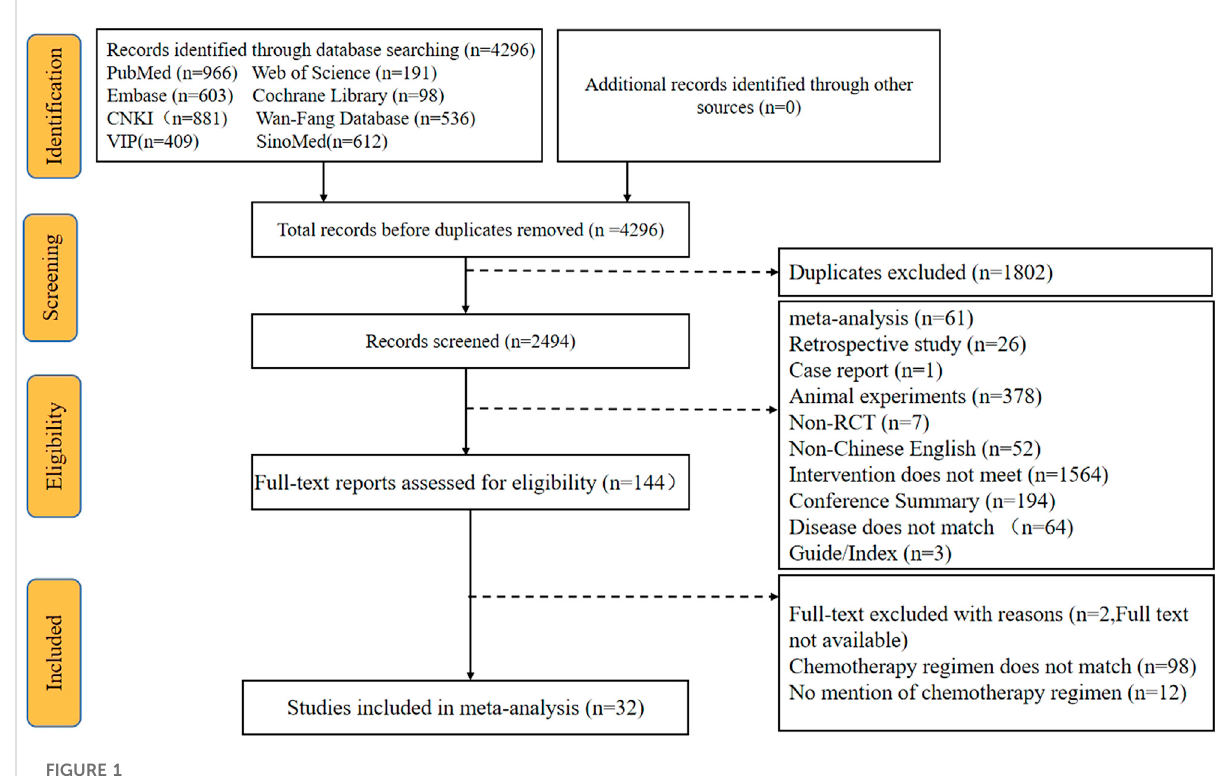
FIGURE 1 Flow chart of the search for eligible